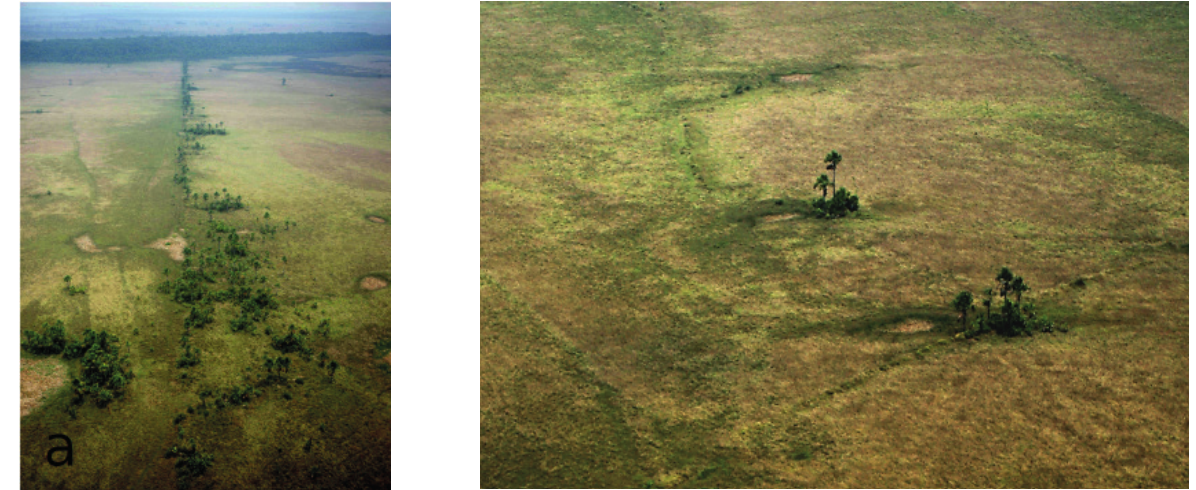
Figure 2 - Left panel: Vestige of a human-made earthen causeway built across a seasonally fl ooded savanna, from one area of well- drained forest to another, near Baures, in the Llanos de Mojos, Bolivia. Right panel : Vestige of a pre-Columbian earthen fi sh weir (V-shaped earthworks joined by linear dikes) in the same site. See Blatrix et al. (2018) for more information about this site. Both photos courtesy of Bruno Roux, Société Avion